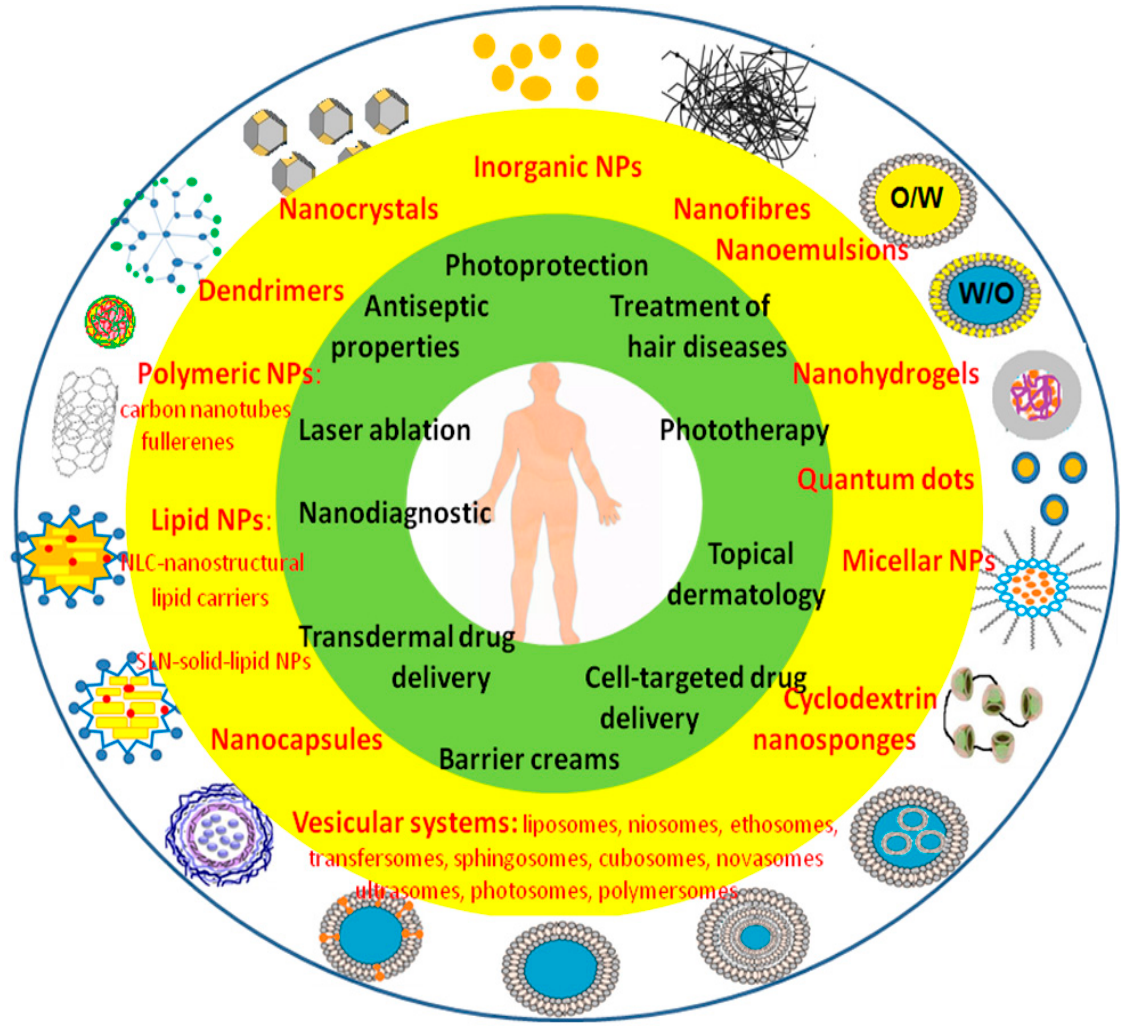
Figure 2. Schematic illustration of different nanoparticles and their applications for topical treatment in